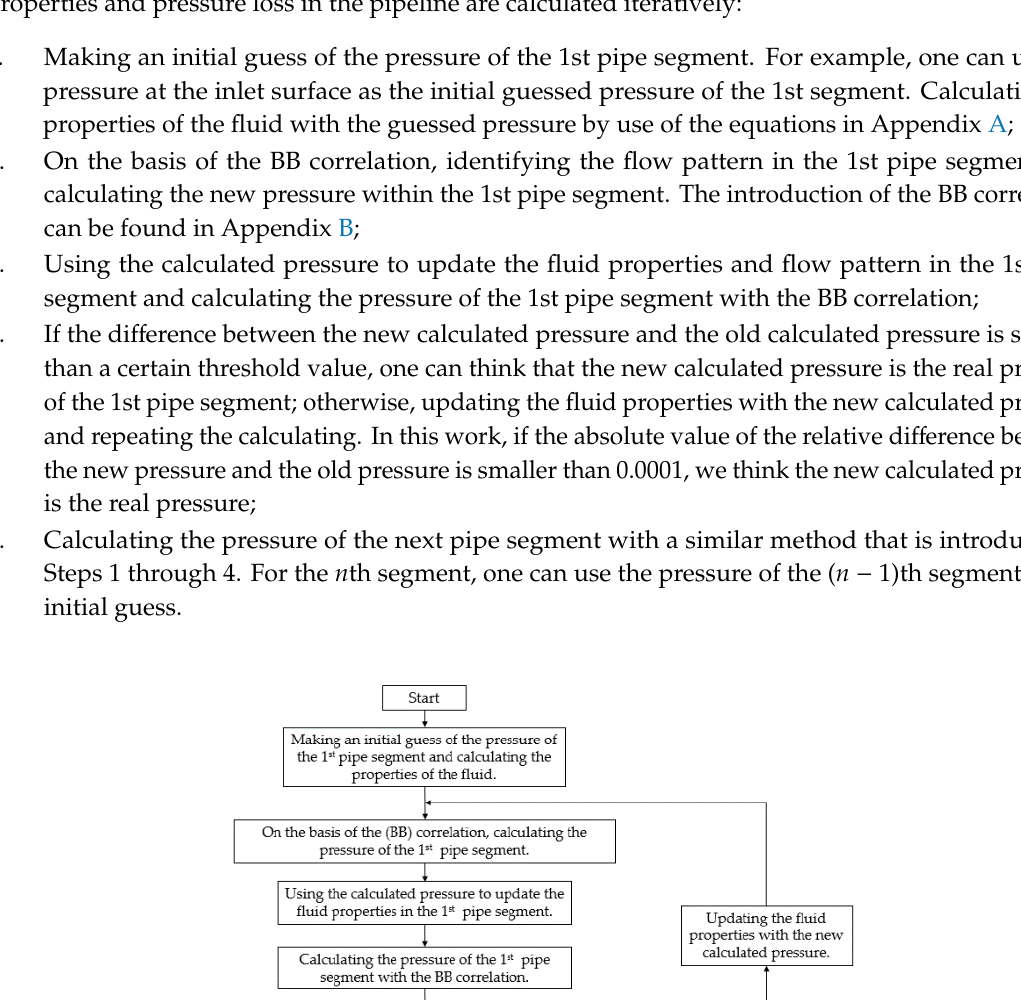
Figure 7. Schematic of a discretized pipe.